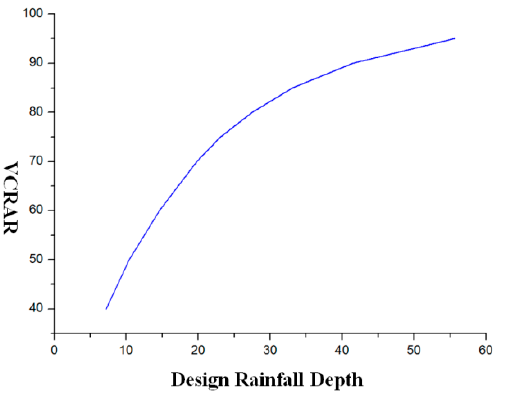
Figure 6. Corresponding relationship between VCRAR and Design Rainfall Depth in Jizhou.